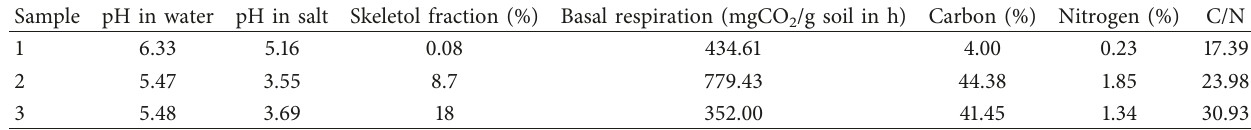
Table 1: General characteristics of soils.